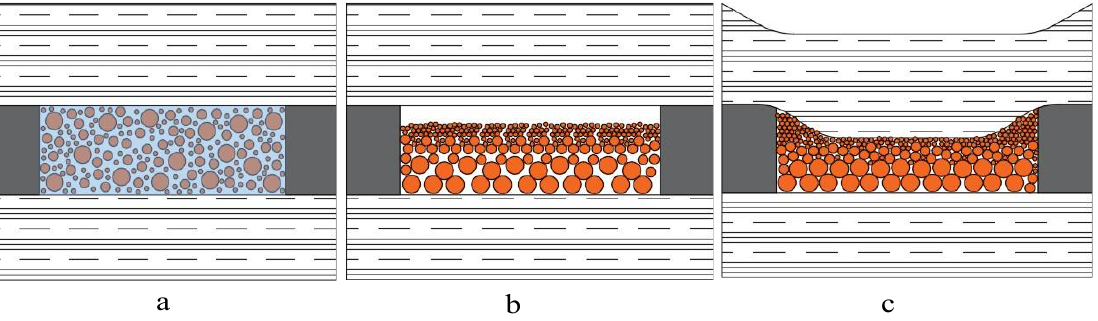
Figure 6. ( a ) Beginning of activation; ( b ) middle of activation; ( c ) end of activation of the hydraulic flushing backfilling material.